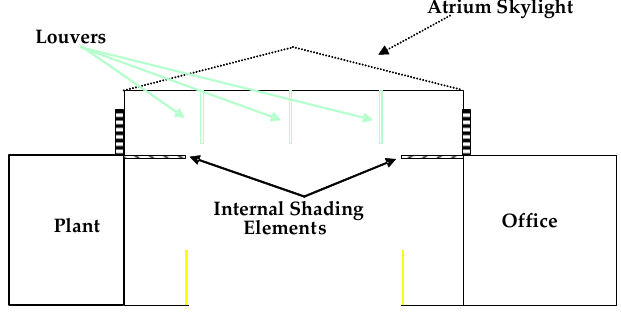
Figure 7. The proposed internal shading element for the Level 13 corridor.